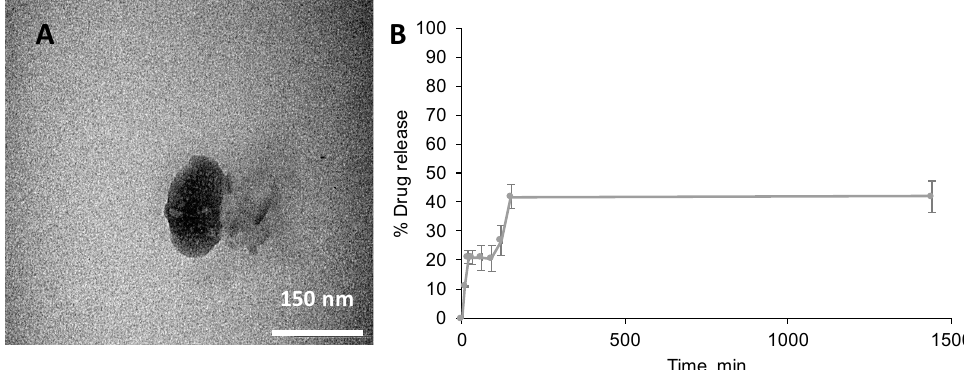
Figure 4. Properties of PAA-Ox5-HNPc+paclitaxel (PTX) loaded formulations. ( A ) TEM image of nano-aggregate and ( B ) drug release profile over 24 h carried out at room temperature ( n = 3, ± SD). Drug release from PAA-Ox5-HNPc+PTX was measured over 24 h (Figure 4B). The data